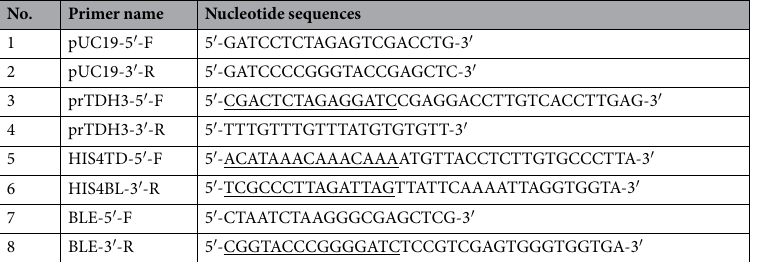
3 ′ -R 32 . Linear pUC19 DNA (Takara Bio, Japan) was prepared by PCR amplification with primers pUC19-5 ′ -F and pUC19-3 ′ -R (Table 1). The four amplified fragments were purified using a QIAquick gel extraction kit, connected by the In-fusion cloning method (Takara Bio, Japan), introduced into E . coli DH5 α by using the heat shock method 33 , and screened on LB plates containing ampicillin, IPTG and X-Gal. Transformants harboring pUC19 containing a TDH3 - HIS4 - ble fragment (3,905 bp) were confirmed by colony PCR. The TDH3 - HIS4 - ble fragment was amplified by PCR and directly introduced into Kmmig1 by the lithium acetate method 34,35 . Transformants